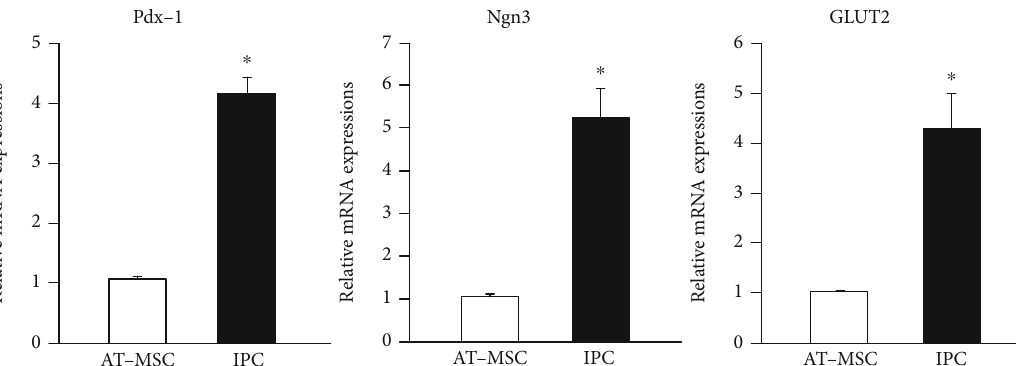
Figure 2: Expression of endocrine pancreatic marker genes in undi ff erentiated and di ff erentiated adipose tissue-derived mesenchymal stem cells. Pdx-1, Ngn3, and GLUT2 mRNA expressions in insulin-producing cells (IPC) generated under the three-dimensional culture system with μ -pieces were 4.1, 5.2, and 4.3 times higher, respectively, than those in undi ff erentiated adipose tissue-derived mesenchymal stem cells (AT-MSCs). Data are expressed as the mean ± standard deviation . ∗ P < 0 : 05 vs. AT-MSC.